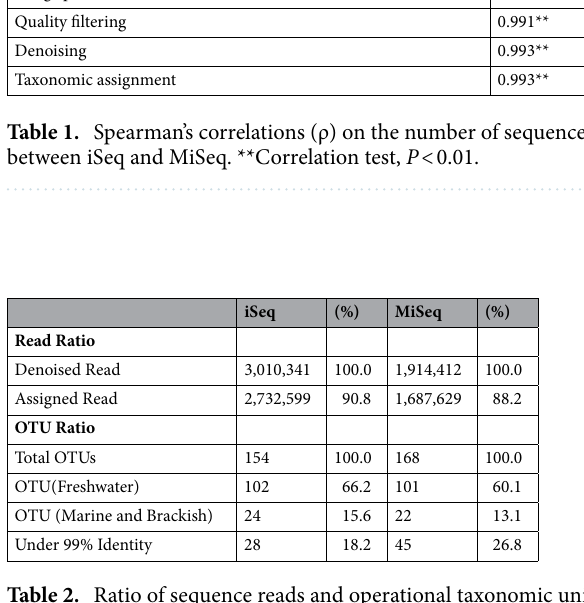
Table 2. Ratio of sequence reads and operational taxonomic unit (OTU) count after